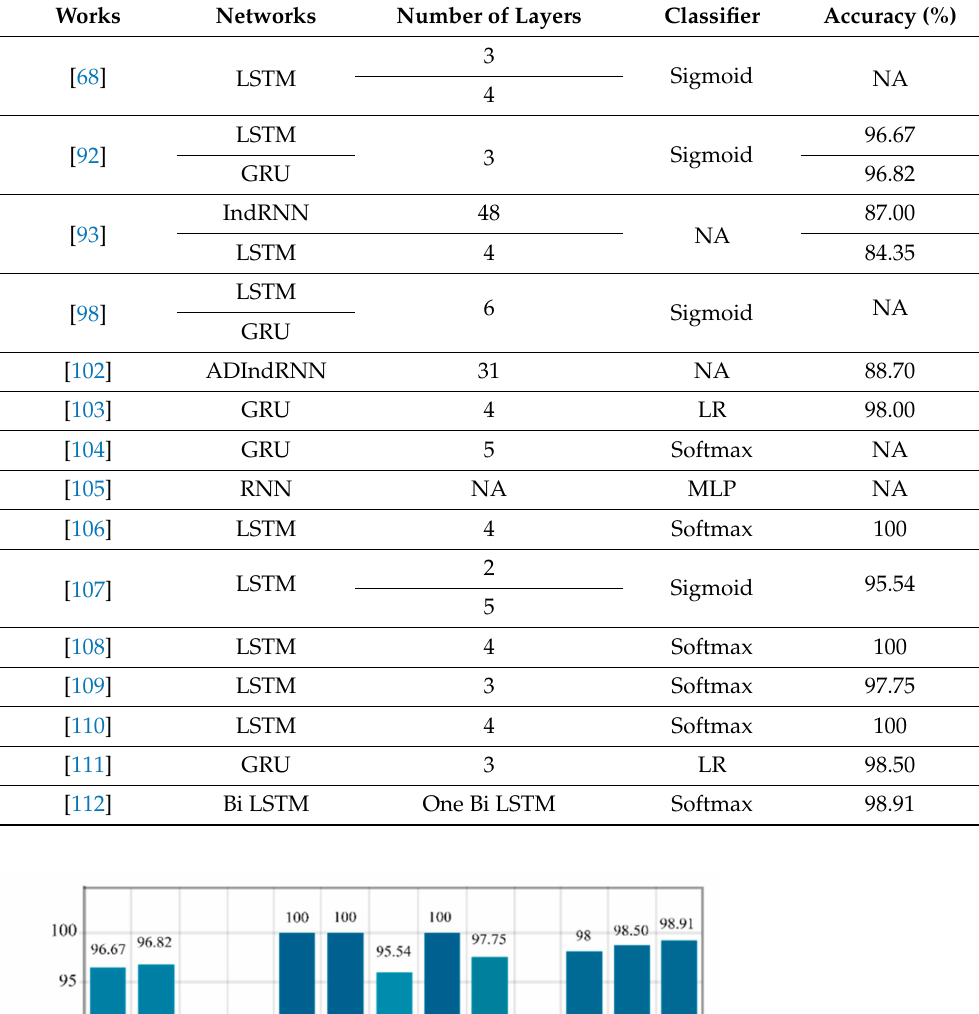
Table 4. Summary of related works done using RNNs.